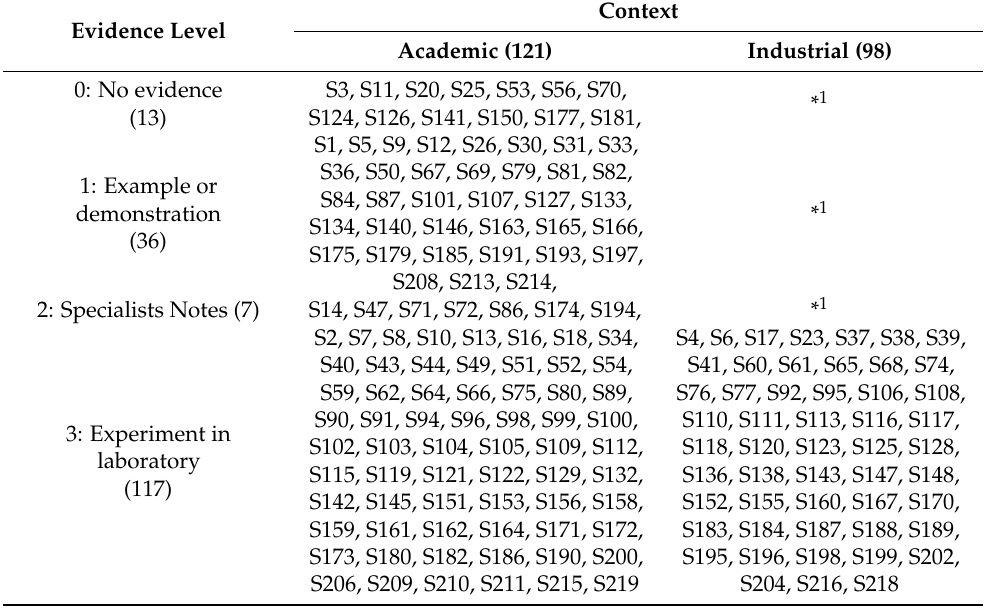
Table 9. Study distribution regarding evidence level and